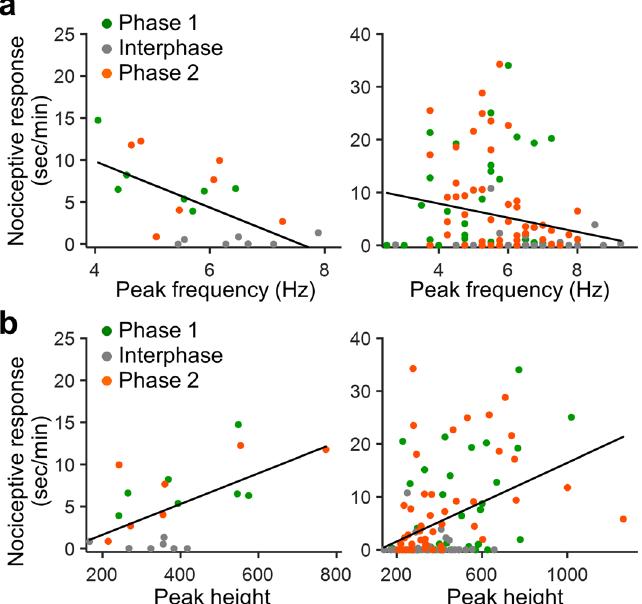
Figure 2. Nociceptive response negatively correlates with the theta-peak frequency and positively with the height. ( a ) Scatter plots depicting nociceptive response plotted against theta-peak frequency. Left: mean values during individual phases in individual animals. Right: values binned by time (2 min) for each mouse. There was a significant inverse correlation of nociceptive response with peak frequency (individual phases: R = − 0.61, P = 0.0036, time-binned values; R = − 0.21, P = 0.018). ( b ) Nociceptive response plotted against theta-peak height. Nociceptive response positively correlates with theta-peak height (individual phases: R = 0.59, P = 0.0049, time- binned values; R = 0.42, P = 0.0000018). R: correlation coefficient, Pearson’s